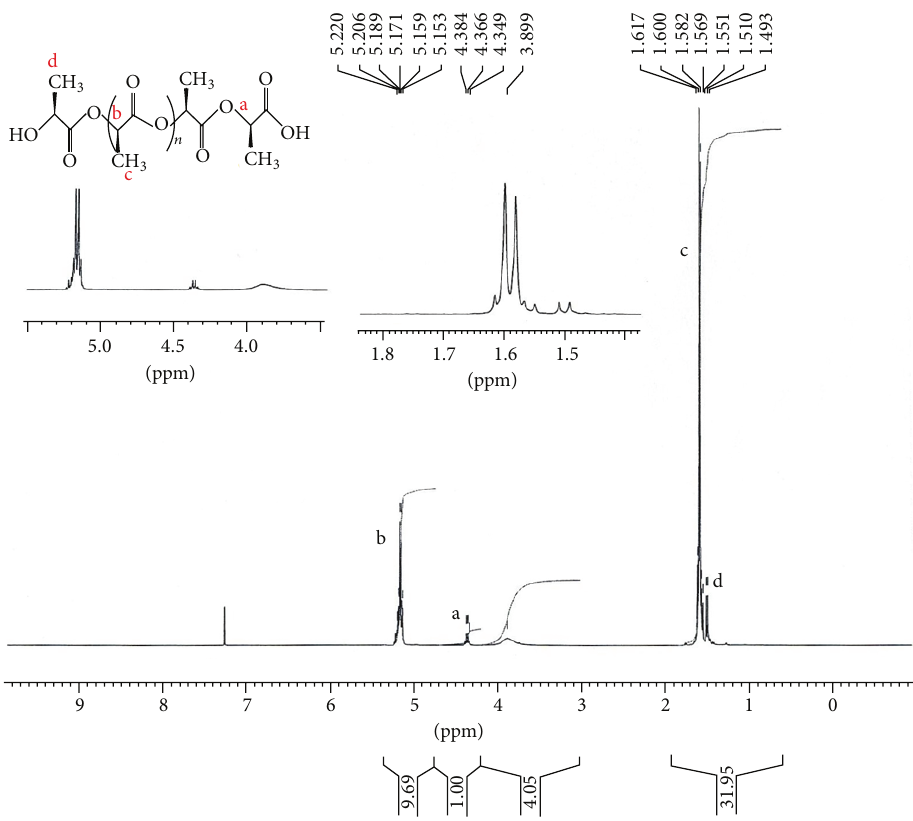
Figure 4: Spectrum 1 H-NMR of